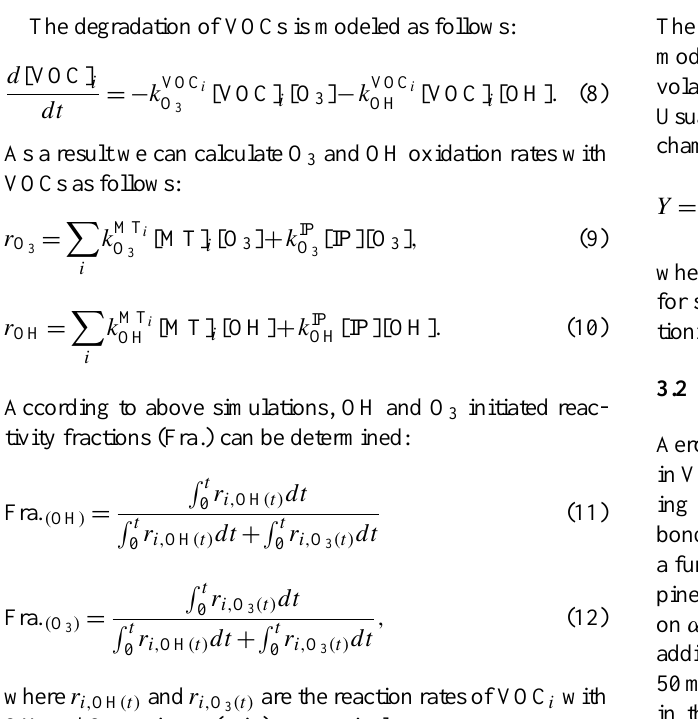
Fig. 2. Exp. R1024: (a) The time evolution of α -pinene concentration. Blue curve: change of α -pinene concentration due to the dilution of ozone addition into the chamber; Black curve: α -pinene decay profile from the chemical kinetic model; Black markers: α -pinene decay profile from PTR-MS measurement; Red curve: changes in α -pinene concentration upon reaction (excluding the dilution effect); Green line: ozone concentration at inlet of chamber. (b) SOA mass yields as a function of aerosol concentration. The red empty rectangles are shown from the experimental data by using the determined aerosol density 1.4 g cm -3 and the red dotted line were fitted by a two-product partitioning model with values 0.3326, 0.0760, 0.0129 and 2.6826 for α 1 , K om,1 , α 2 , and K om,2 , respectively. The black compact rectangles shown are adjusted to ρ =1.0 g cm -3 to facilitate the comparison with other studies.